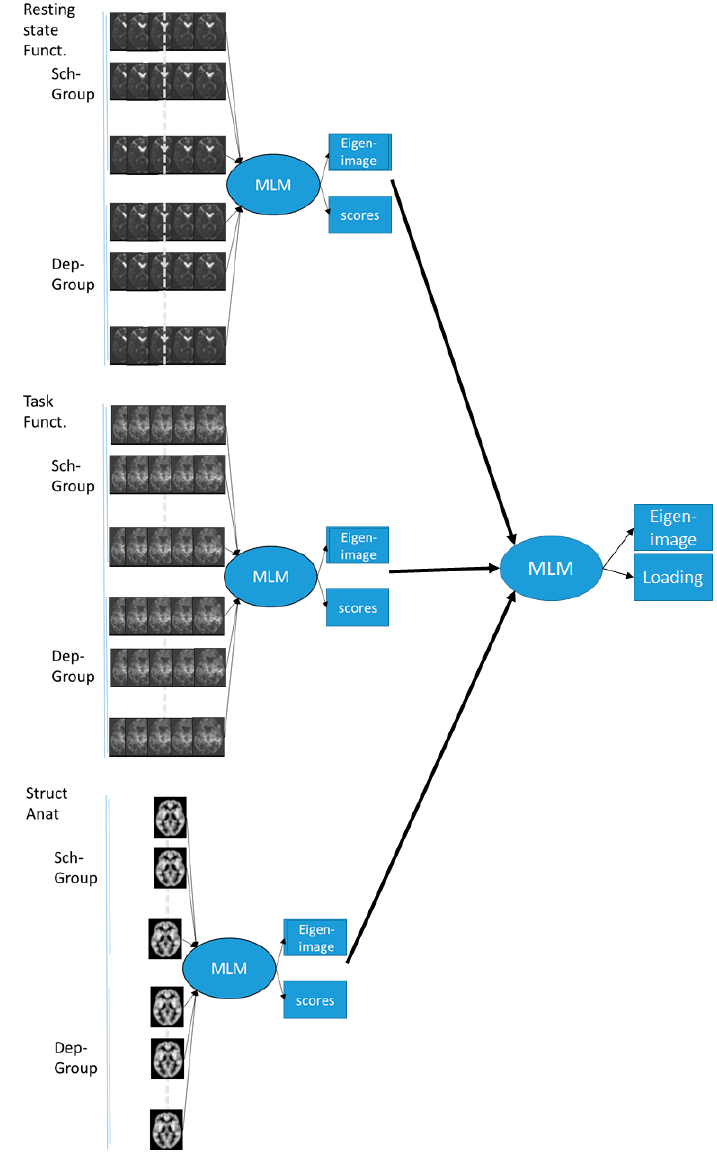
Figure 1. Schematic representation of the multimodal multivariate linear method (MLM) approach. Multi-modal MLM takes place in two stages. First, separate MLMs are done for each modality. Each MLM analysis will identify the eigen-image (brain signature) and the corresponding subjects’ scores that best explain the differences between the two groups. In the second step, we use MLM and the eigen-images (or the scores) from the previous stage to identify the best combinations of the modality-specific signatures and the corresponding combined brain signatures.